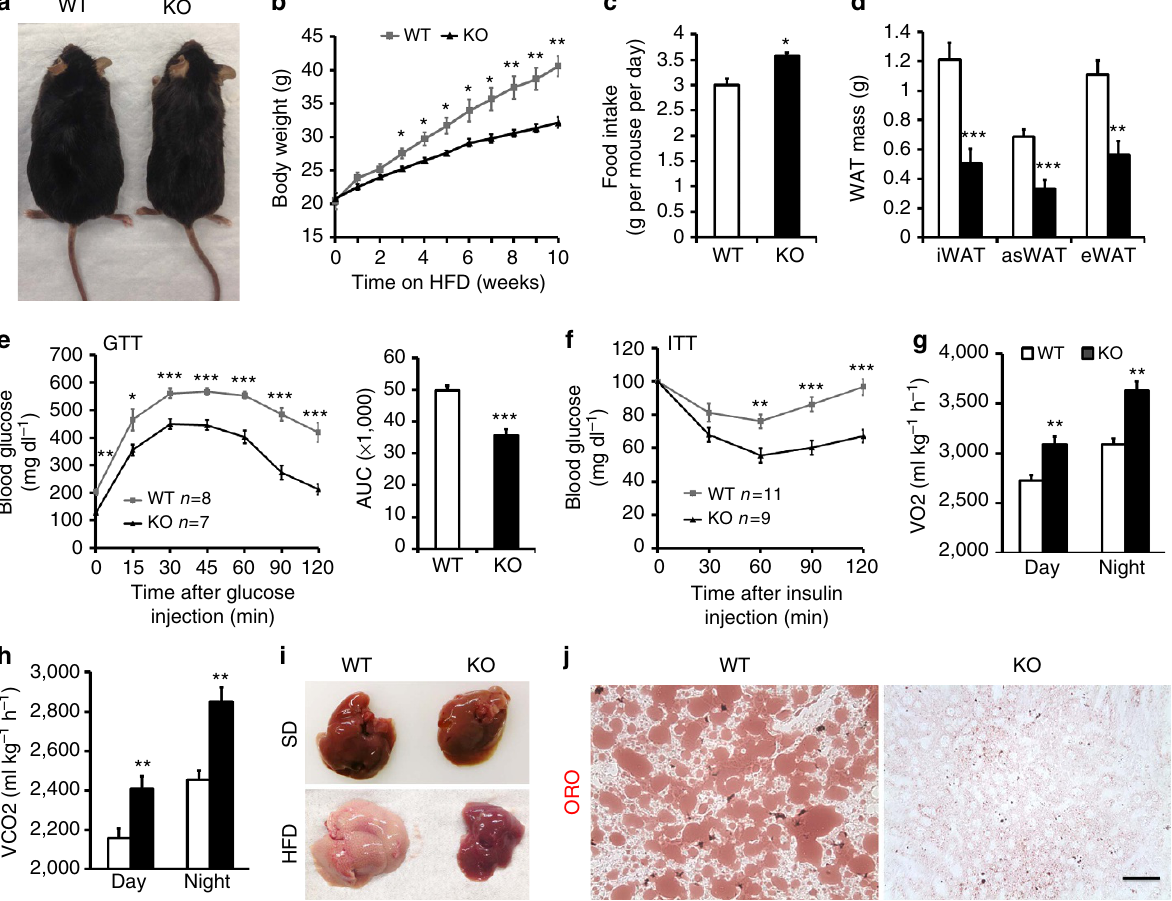
Figure 4 | Adipocyte-specific deletion of Lkb1 protects mice against high-fat diet (HFD)-induced obesity. ( a ) Representatives of WT ( Lkb1 flox/flox ) and KO ( Adipoq-Lkb1 ) mice fed with HFD for 12 weeks. ( b , c ) Growth curve ( b ) and feed intake ( c ) of WT ( n ¼ 6) and KO ( n ¼ 7) mice during HFD